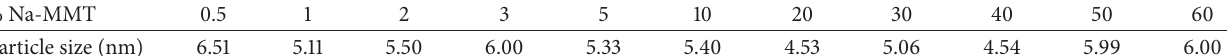
Table 1: Particle sizes of CeO 2 /montmorillonite nanocomposite films calculated from XRD patterns using the Scherrer equation for the (111) reflection.